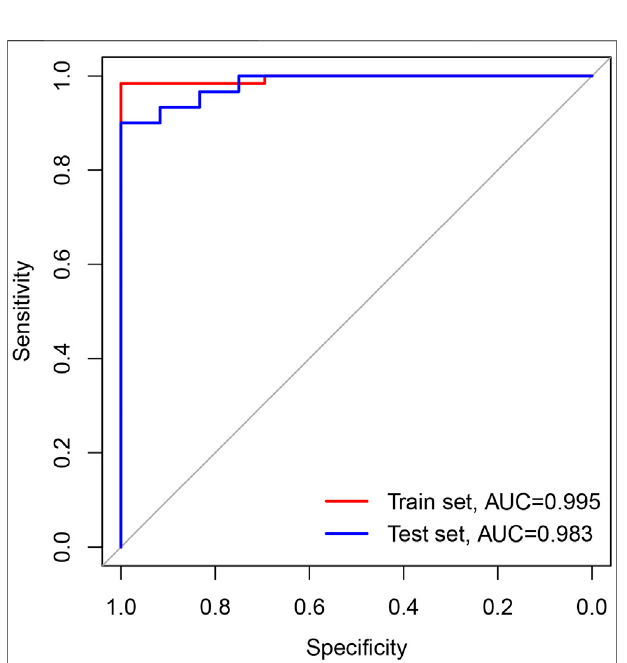
FIGURE7| ROCcurvebasedonGEOdatabase.Theredlinerepresents train set and the blue line represents test set.